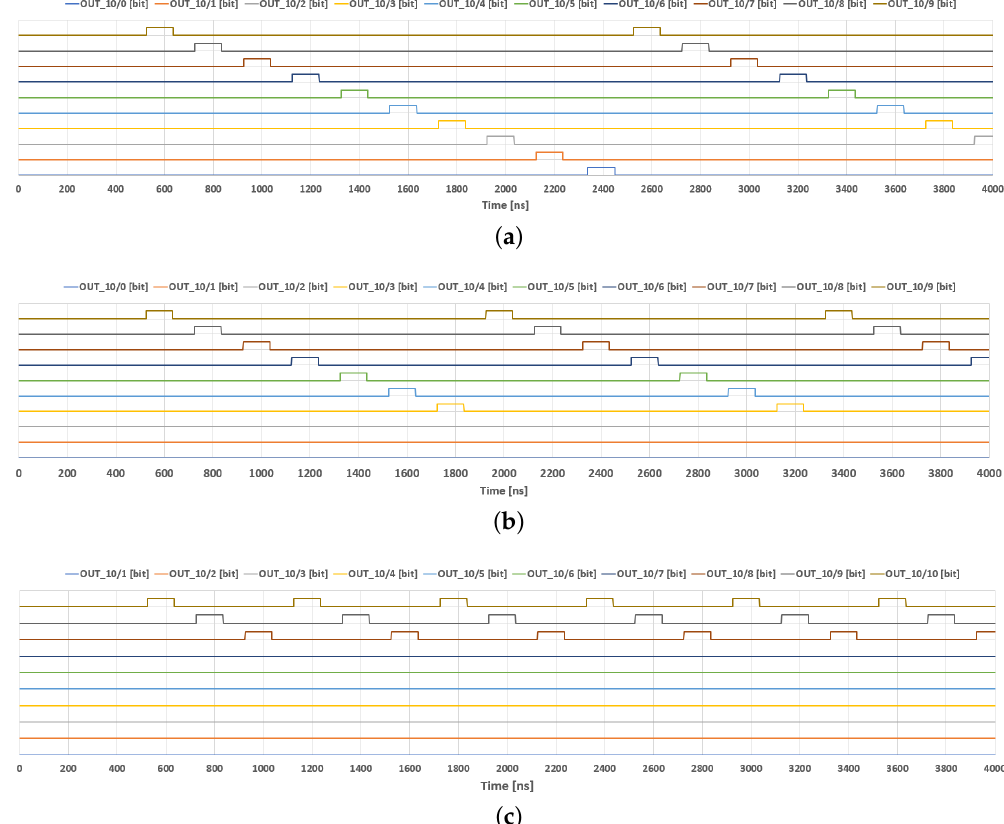
Figure 10. Measurement results of the implemented clock generator for selected numbers of clock phases in a single cycle: ( a ) 10; ( b ) 7; and ( c ) 3.